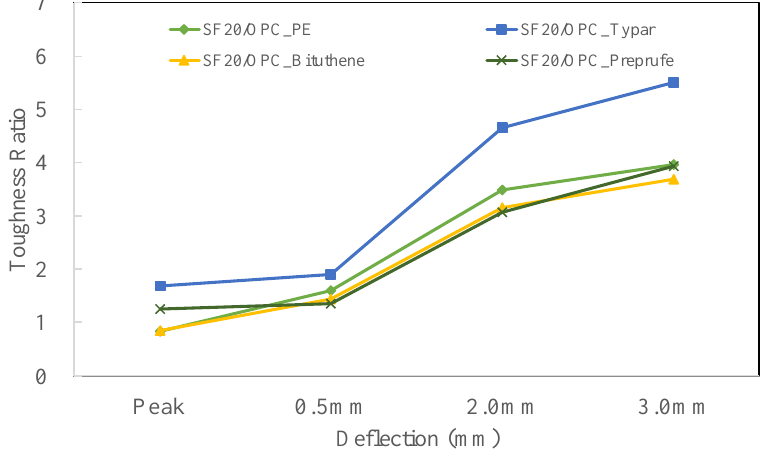
Figure 9. Toughness ratio between SF20 and OPC with waterproof reinforcement.